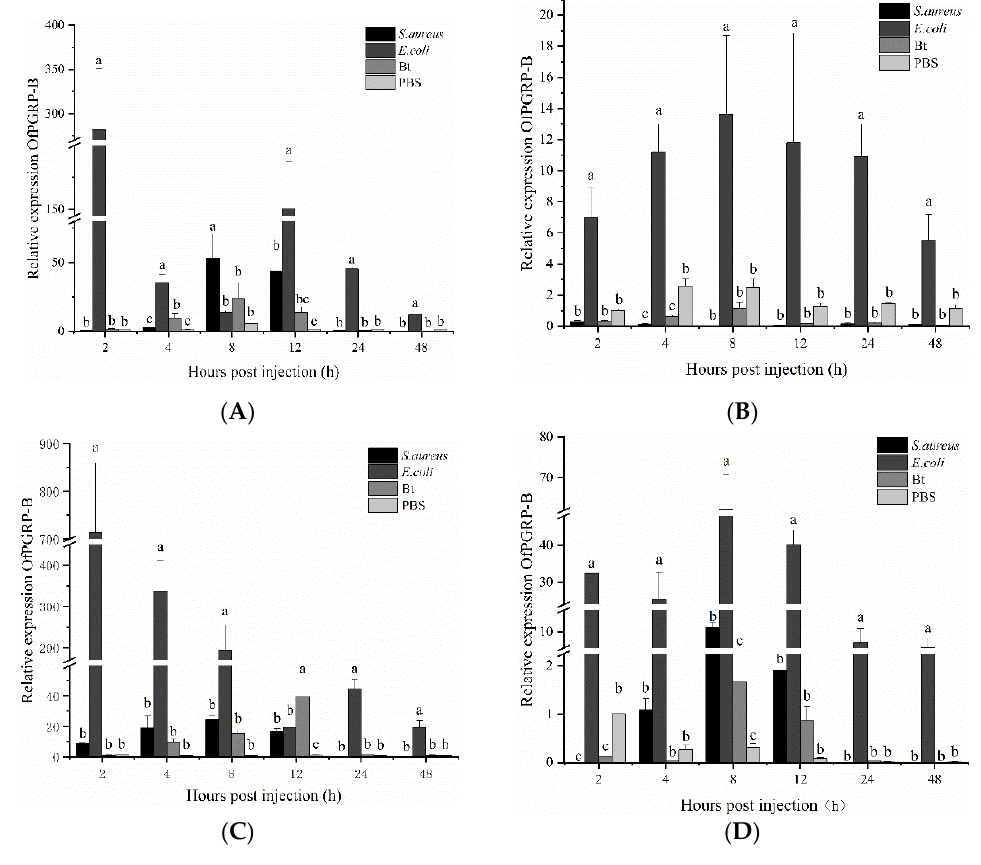
Figure 6. Expression levels of OfPGRP-B in different tissues of 4th instar larvae of Ostrinia furnacalis after injection with different pathogens:( A ) epidermis;( B ) hemolymph;( C ) fat body;( D ) midgut. PBS: PBS buffer; Bt: Bacillus thuringiensis ; Staph: Staphylococcus aureus ; RIL: Escherichia coli. The small letters represent a signifificant difference (one-way ANOVA, followed by Tukey’s test as post hoc, p < 0.05).